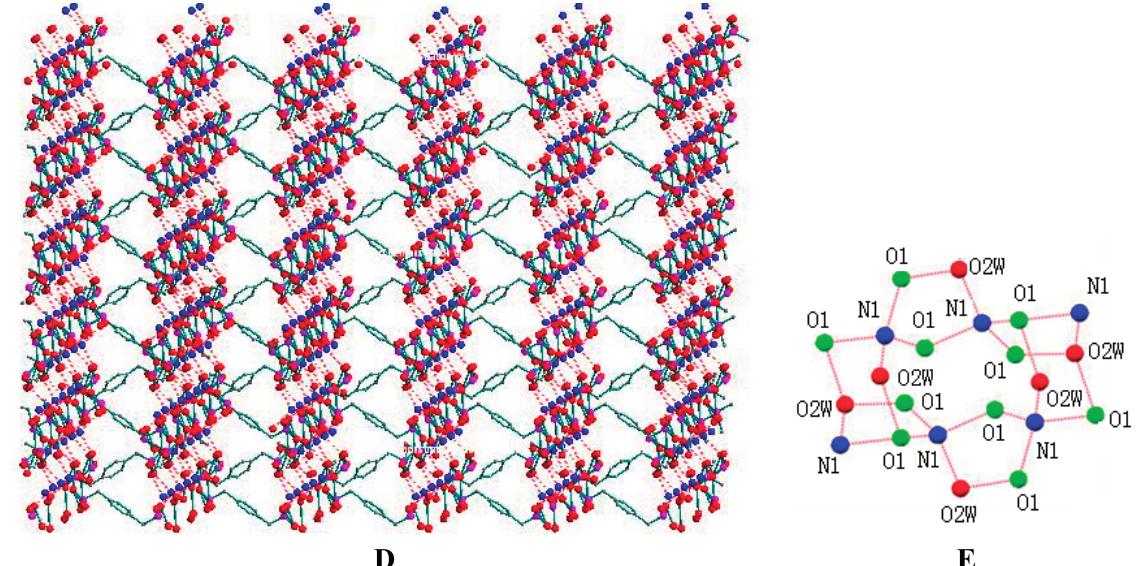
D E Figure 3. ( A ) Molecular structure of 3 with atomic numbering; ( B ) 1D chain joined through N1-H1···O1 and N1-H6···O2 hydrogen bonds; ( C ) 2D supramolecular network viewing along the c axis in the unit cell; ( D ) view of the 3D architecture and ( E ) stable connection mode among atoms of oxygen and